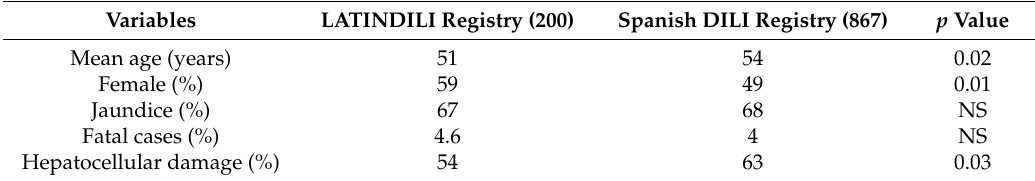
Table 3. Comparative data between the Spanish and the LATINDILI Registries